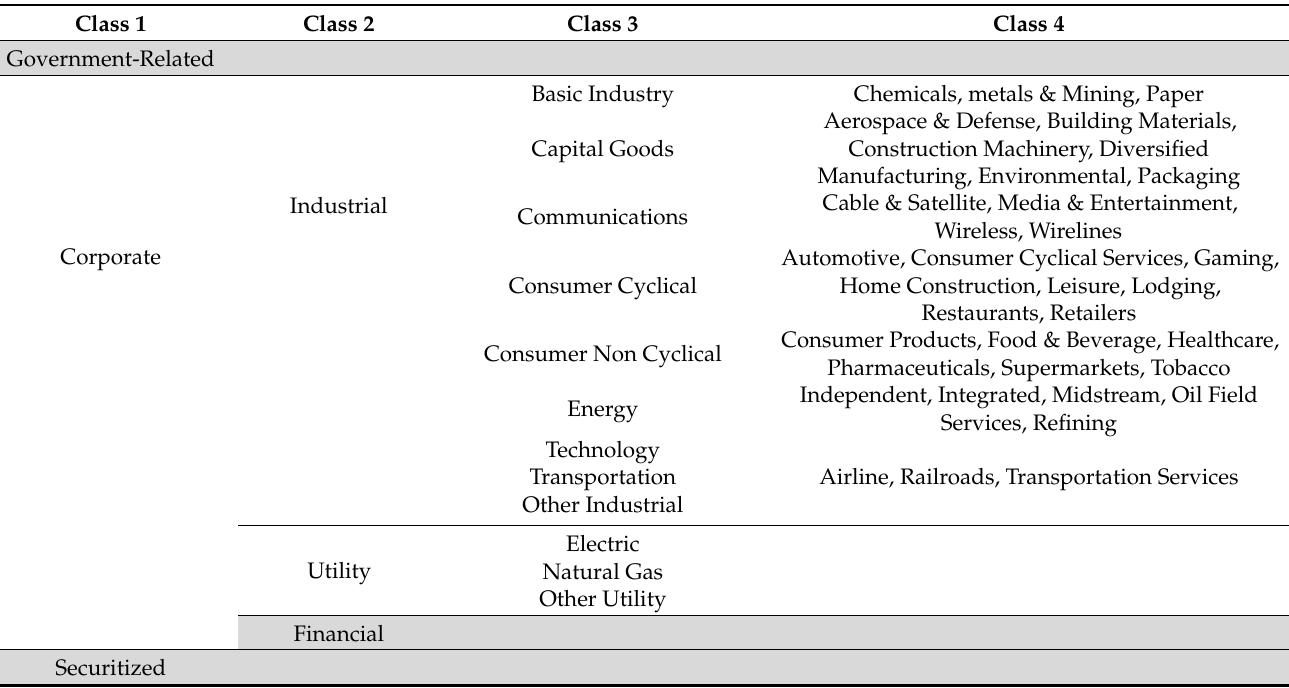
Table 2. Bloomberg Barclays Global Sector Classification